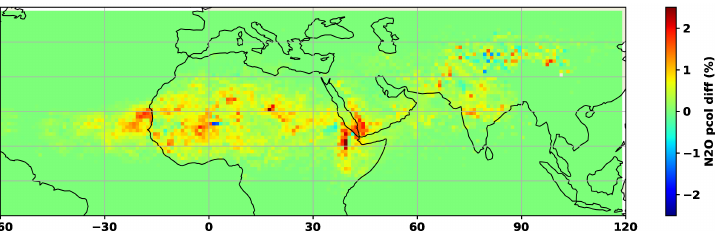
Figure 8. Monthly average for June 2018 of the difference between the retrieved N 2 O partial column using simple quality control or with the additional dust filter.